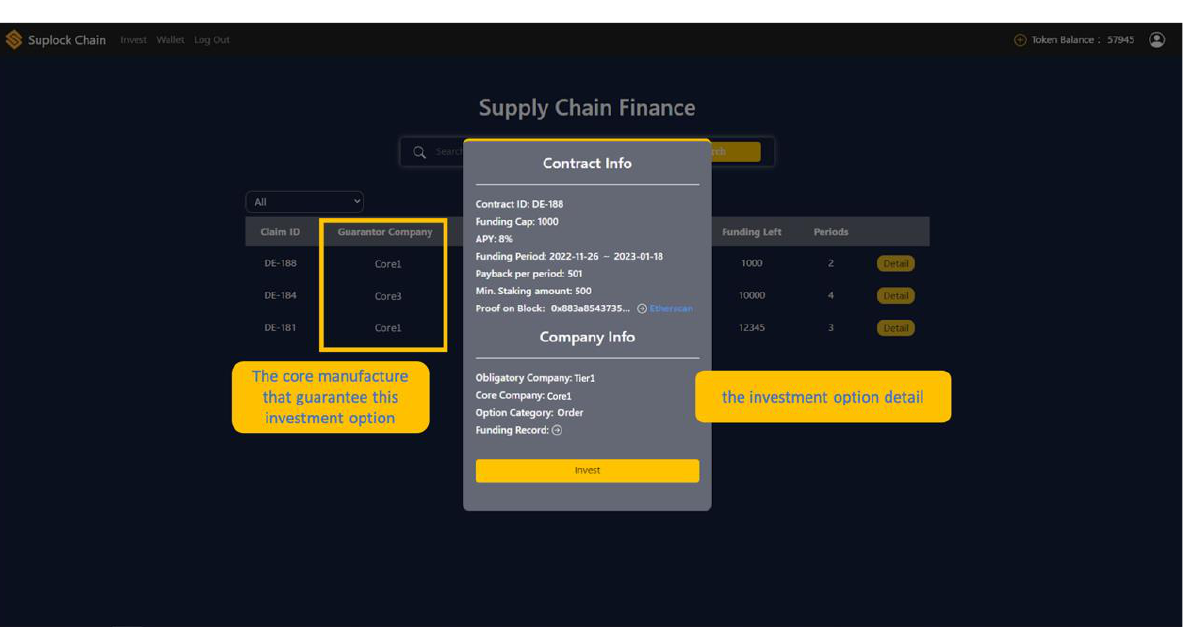
Figure A20. Module for listing right-type CTs that are available for investment on our website.